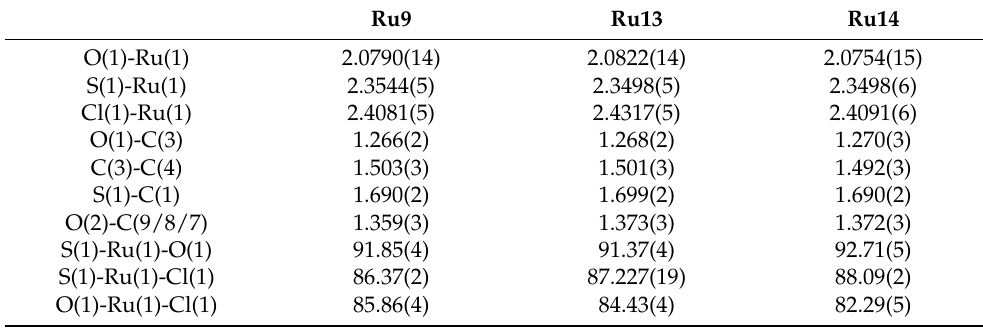
Table 2. Bond angles [ ◦ ] and bond lengths [Å] for characterized ruthenium(II)